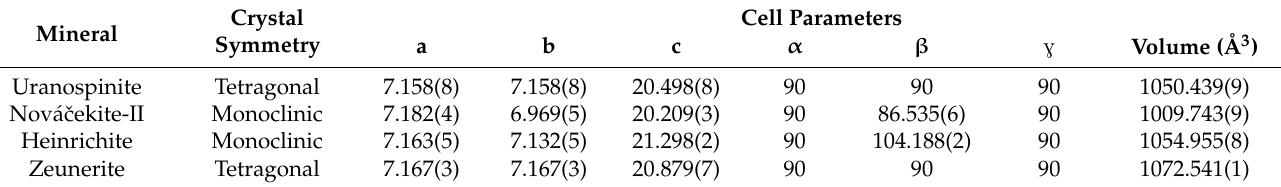
Figure 3. XRD patterns of uranyl arsenates from Podg ó rze mine. Usp, uranospinite; Nvˇc-II, nov á ˇcekite-II; Hrc, heinrichite; Zeu, zeunerite. Table 1. Unit cell parameters of uranyl arsenates from Podg ó rze